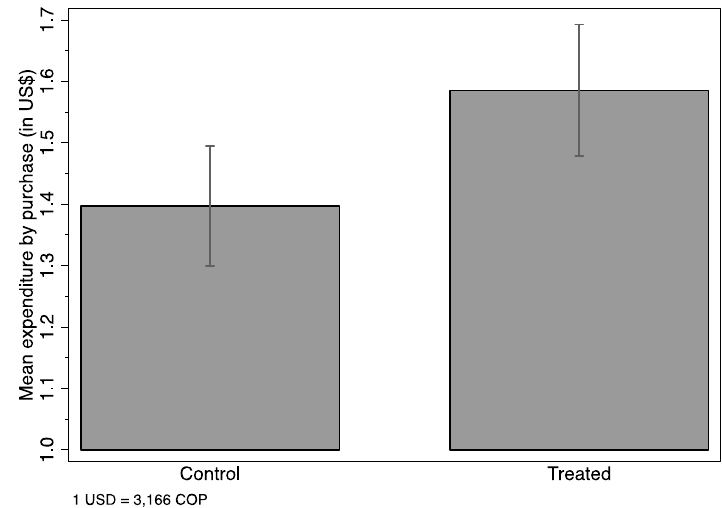
Figure 3. Mean expenditure by purchase of treated and control groups. Notes: This figure shows total expenditure regardless of the item’s color, among control and treated subjects, in USD. The vertical whiskers refer to the 95% confidence interval. The vertical axis starts at $1. Nutrients 2018 , 12 , x FOR PEER REVIEW